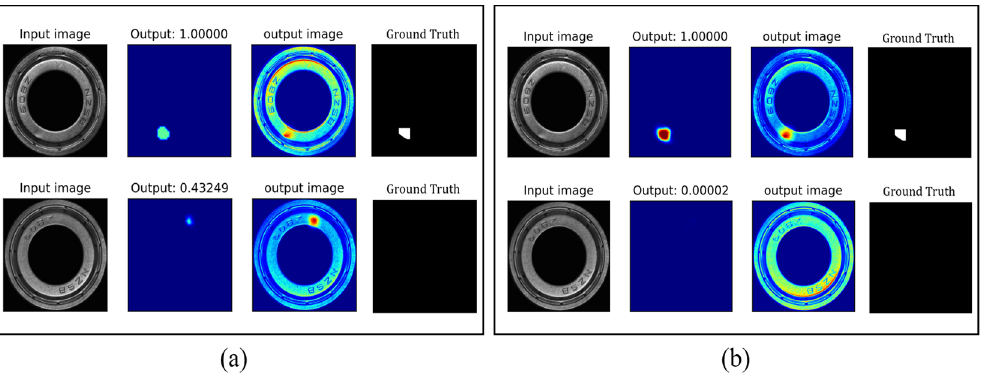
Figure 12. Comparison of weight label results. ( a ) Without weight label. ( b ) With weight label. The first row is defective data. The second row is non-defective data.